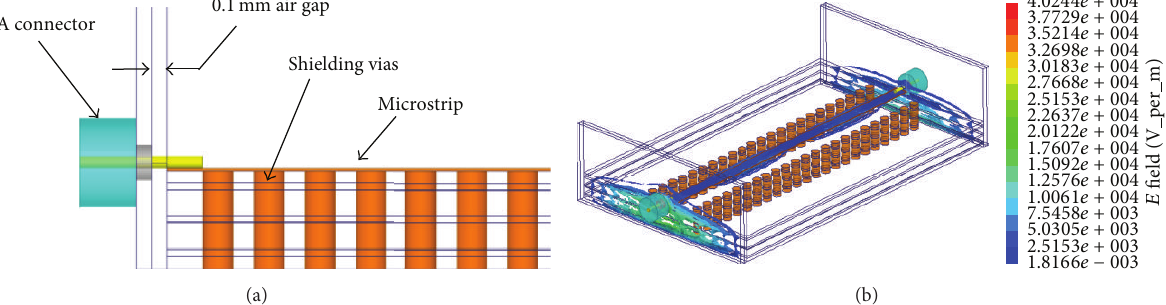
Figure 14: A 3D model for imitating the true nature of measurement. (a) Side view of the 3D structure; (b) diagram of the simulated electric